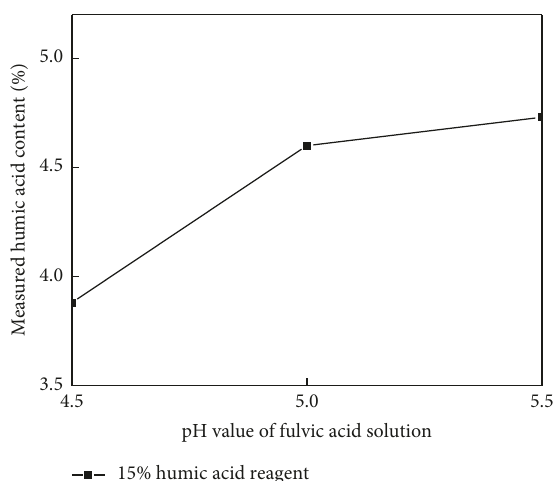
Figure 8: Relationship curve between measured HA content of samples and pH value of FA solution.